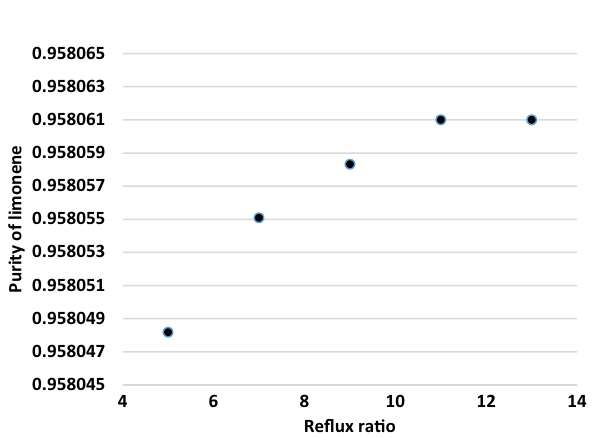
Figure 4. Impact of reflux ratio on the purity value of limonene.